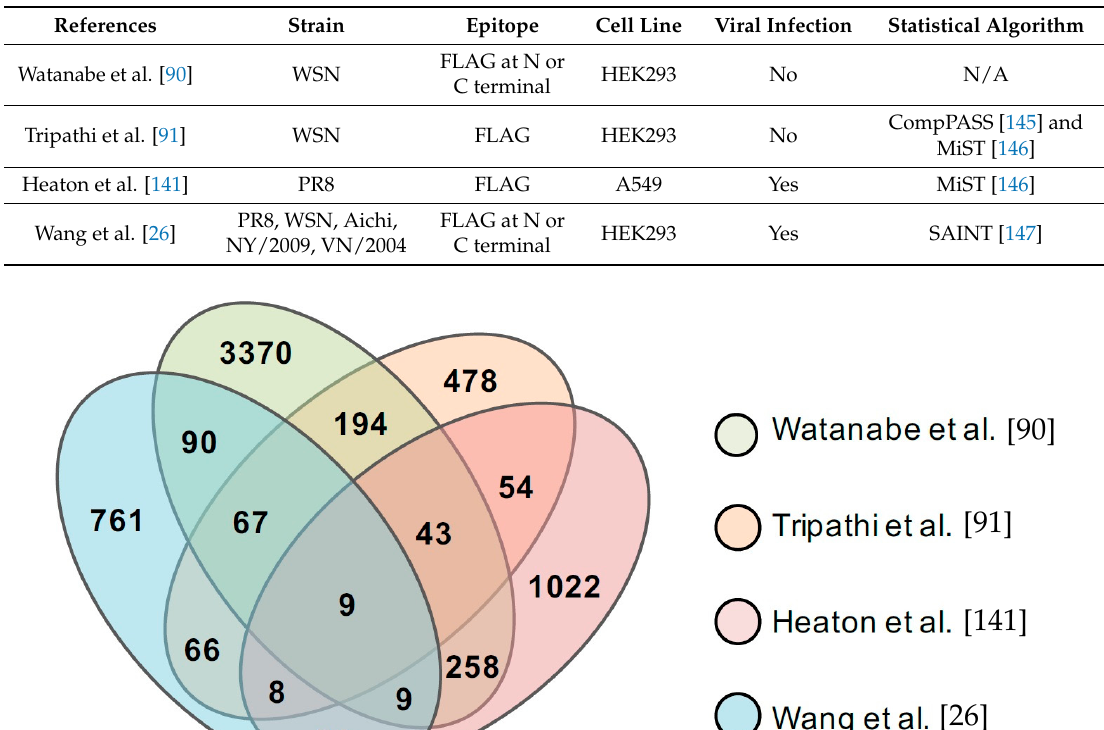
Table 1. Recent IAV–host protein interactomes discussed in the review.